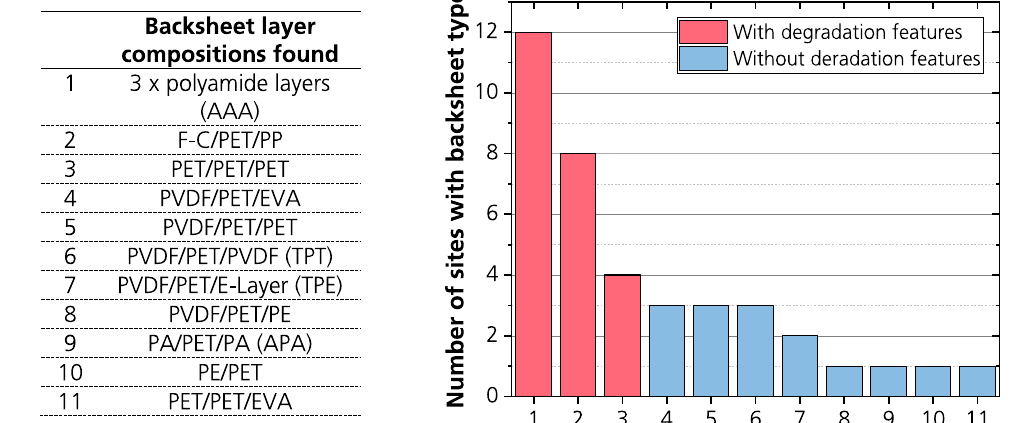
Fig. 1. Left: List of layer structures found in the investigated backsheets; Right: Graph showing the number of sites on which each respective backsheet type